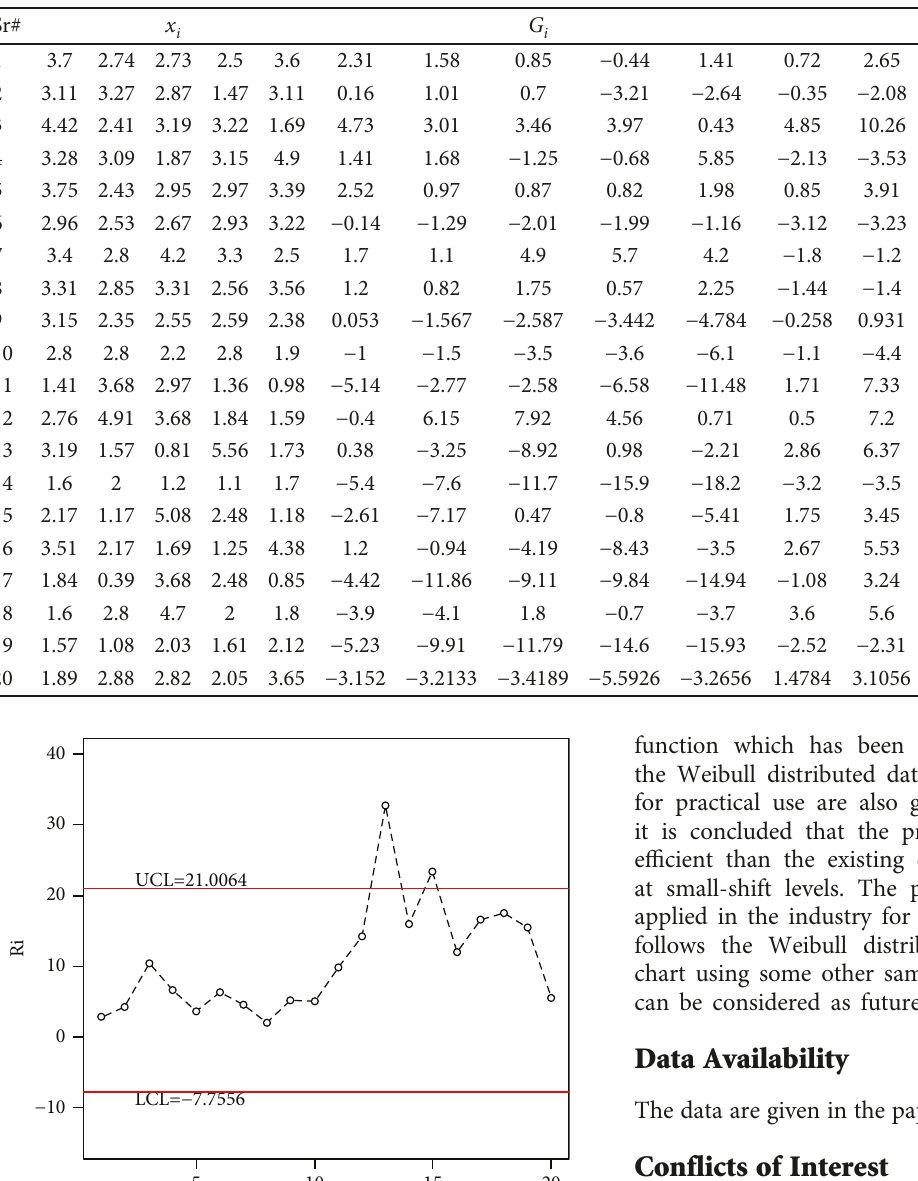
Table 7: The real example data.